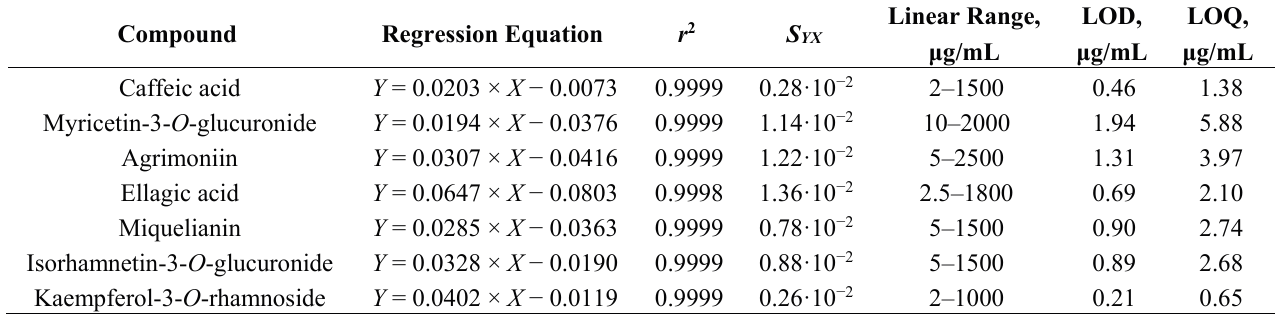
Table 2. Linear regression data, LOD and LOQ of seven compounds from P. anserina . Compound Regression Equation